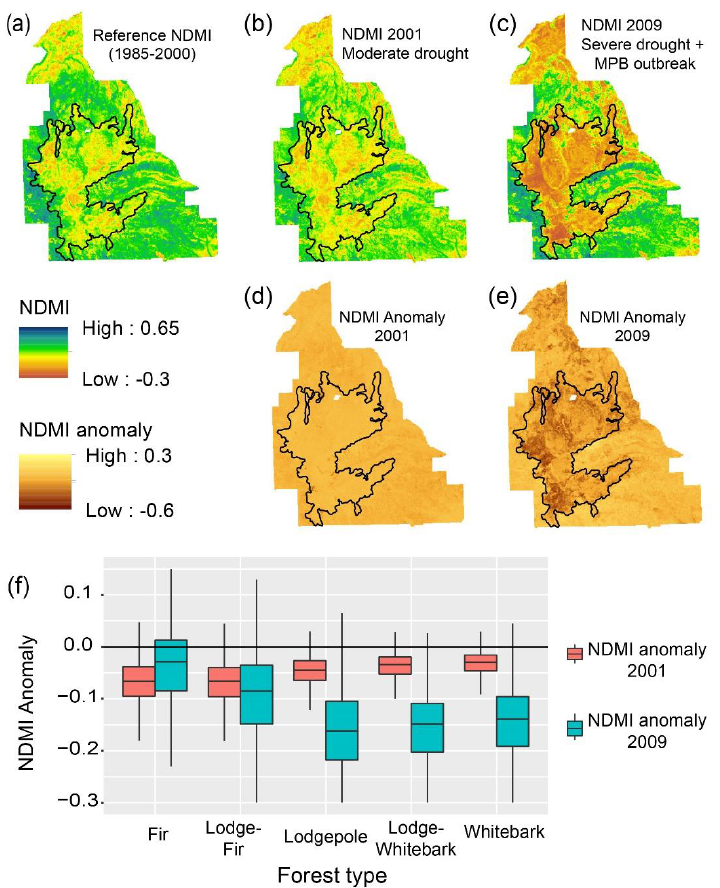
Figure 4. Maps of median August values for normalized difference moisture index (NDMI) over ( a